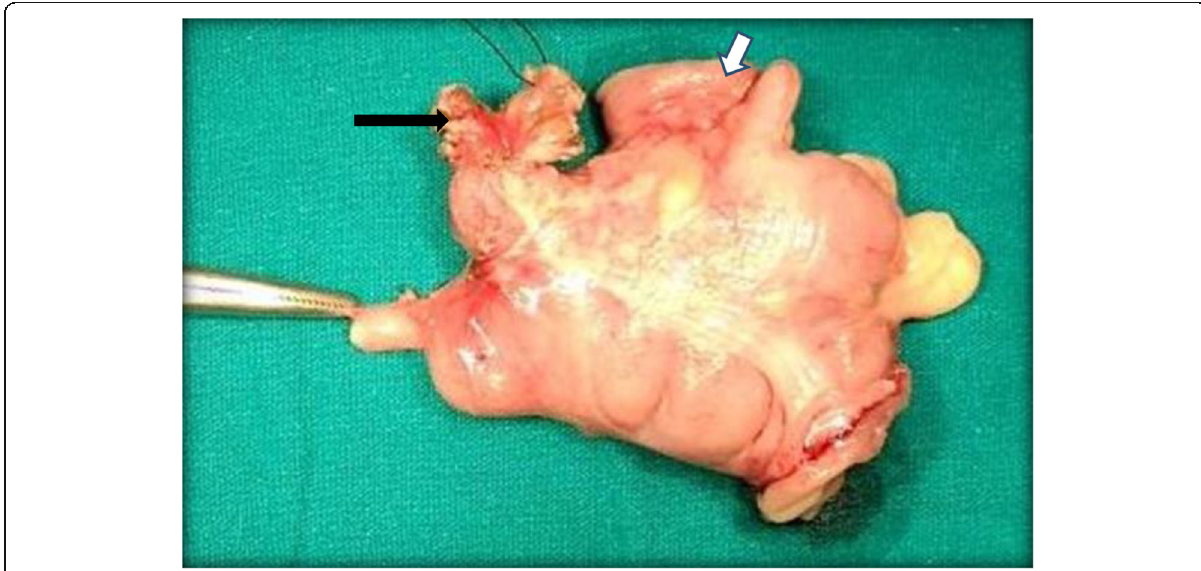
Fig. 3 Excised specimen showing patent vitello-intestinal tract (black arrow), terminal ileum (white arrow), native appendix with cecum (tip of hemostat) alongside duplicated cecum and appendix sharing common